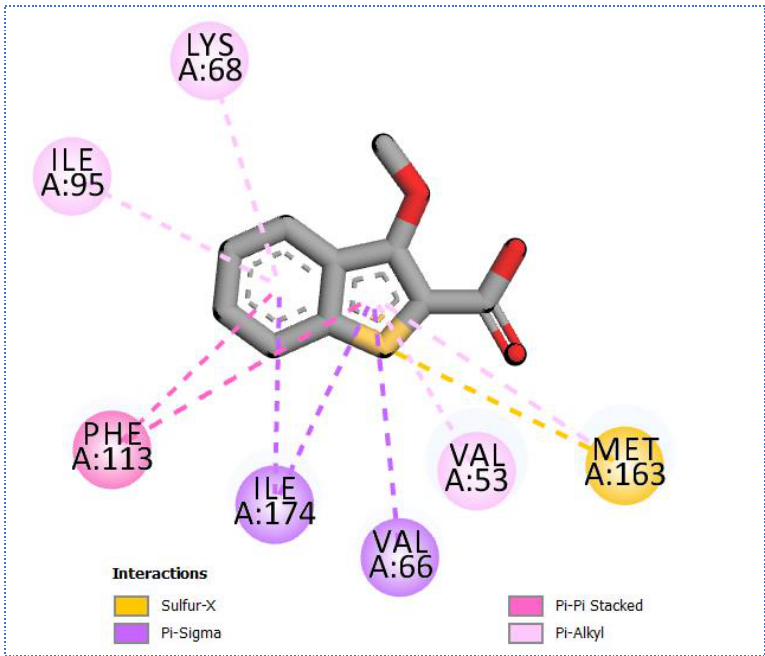
Figure 11. The 2D binding of compound 26 with Casein kinase II subunit alpha (PDB ID: 5csp).